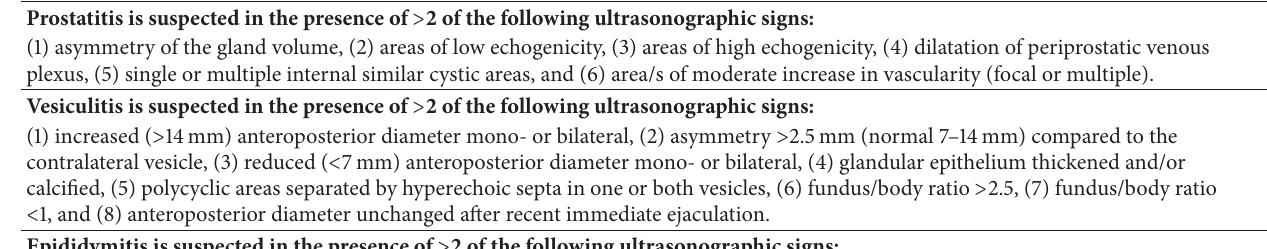
Table 2: Ultrasound criteria for the confirmation and greater characterization of the clinical diagnosis of